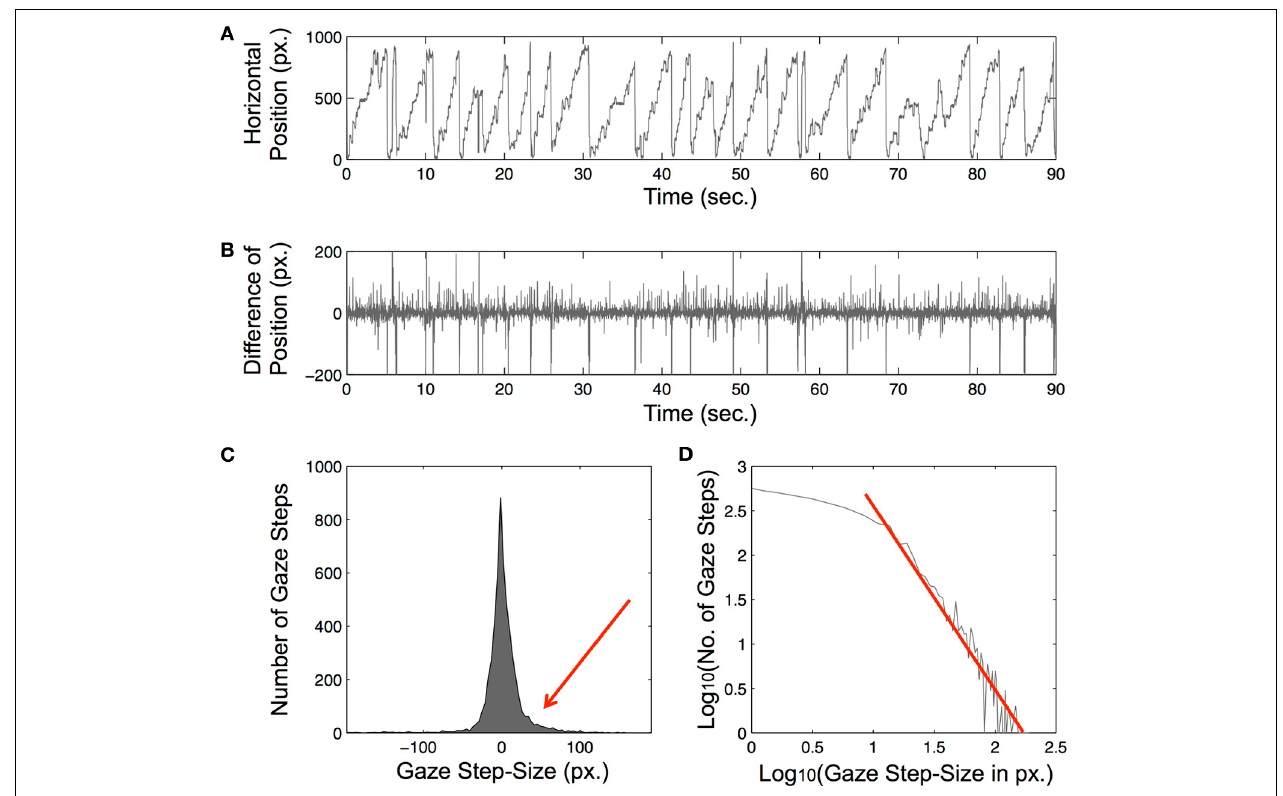
FIGURE 1 | Scaling in eye-movement fluctuations. (A) Record of horizontal eye-gaze positions in pixels during text reading. The data were recorded using an ASL D6 eye-tracker (sampling rate: 60Hz; resolution: 0.25 ◦ ), with 1 pixel ≈ 0.02 ◦ . (B) Difference of position-record (Gaze step-size) from (A) . In this record, periods of large fluctuations indicate saccadic movements, and periods of small fluctuations indicate fixations. (C) Histogram of gaze steps